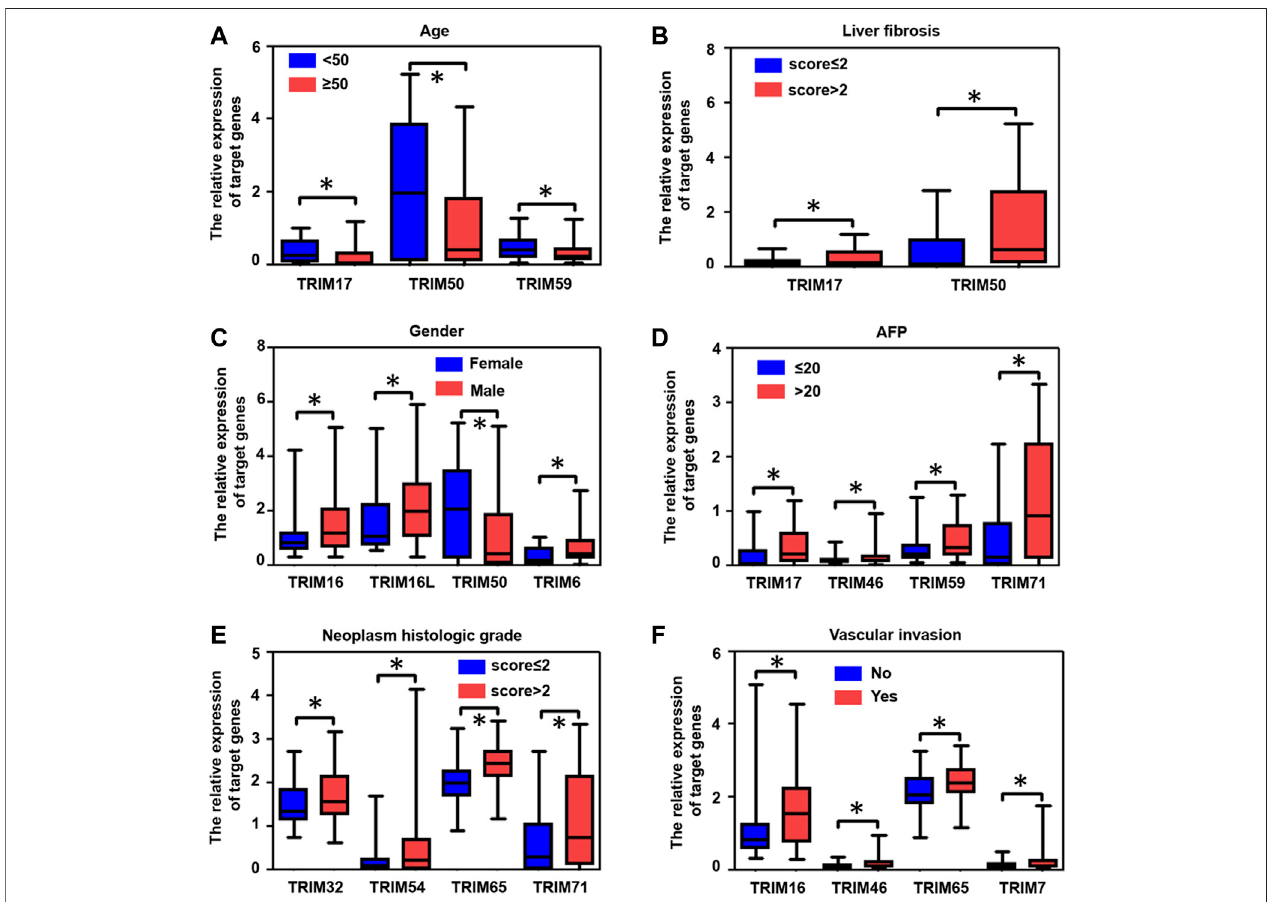
FIGURE 6 | The association of identi fi ed TRIMs with different clinical factors in patients with HBV-positive HCC. (A) The correlation of TRIMs with ages in HBV- positive HCC patients. (B) The correlation of TRIMs with liver fi brosis in HBV- positive HCC patients. (C) The correlation of TRIMs with gender in HBV-positive HCC patients. (D) The correlation of TRIMs with AFP levels in patients with HBV-positive HCC. (E) The correlation of TRIMs with different neoplasm histologic grades in HBV- positive HCC patients. (F) The correlation of TRIMs with or without vascular invasion in patients with HBV-positive